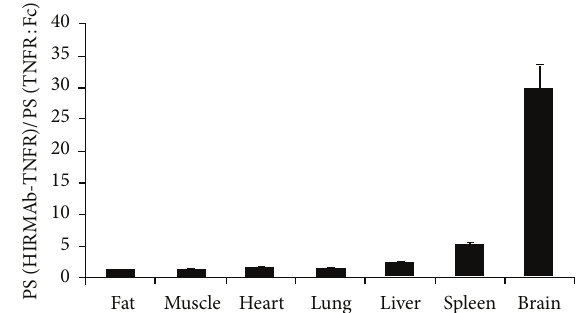
Figure 2: Ratio of the organ PS product for the HIRMAb-TNFR fusion protein, over the organ PS product for the TNFR:Fc fusion protein, is plotted for each organ. The ratio for brain is the mean of the values for frontal gray matter, frontal white matter, cerebellar gray matter, and cerebellar white matter, which varied between 22 and 37 (adapted and modified from Figure 8,